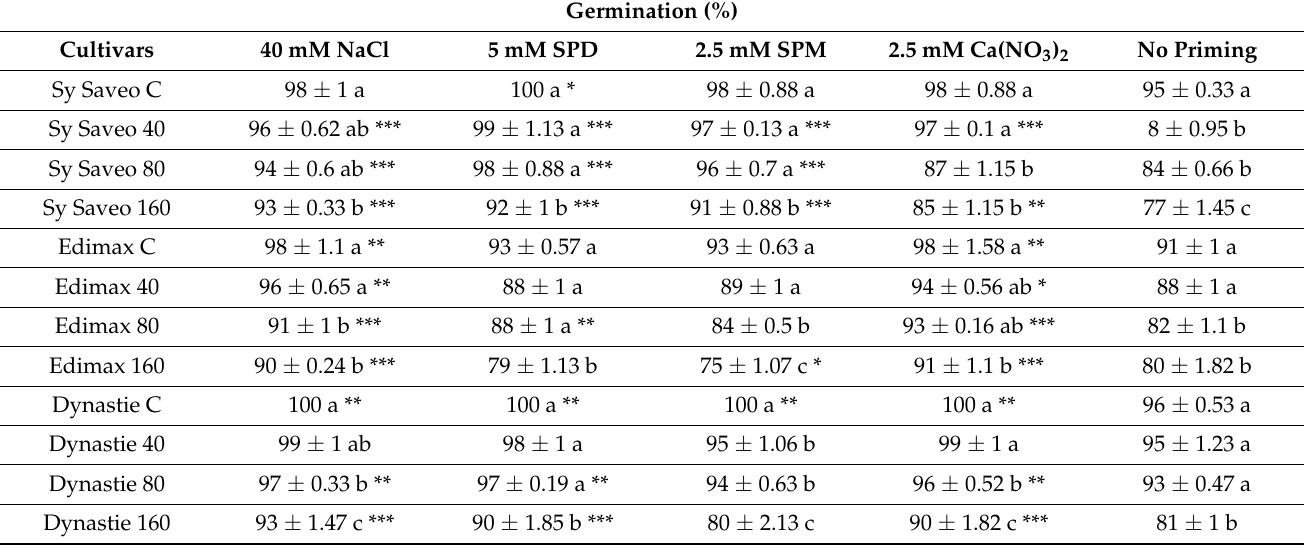
Table 1. Effect of different priming agents on seed germination (%) of rapeseed cultivars exposed to different saline conditions: 0 mM NaCl (C), 40 mM NaCl (40), 80 mM NaCl (80), 160 mM NaCl (160). Data are expressed as means ± SE ( n = 3). Mean values in the column marked by different letters are significantly different within the same group ( p ≤ 0.05; ANOVA and Tukey–Kramer test). Significant differences between groups are reported as * p < 0.05; ** p < 0.01; *** p < 0.001.